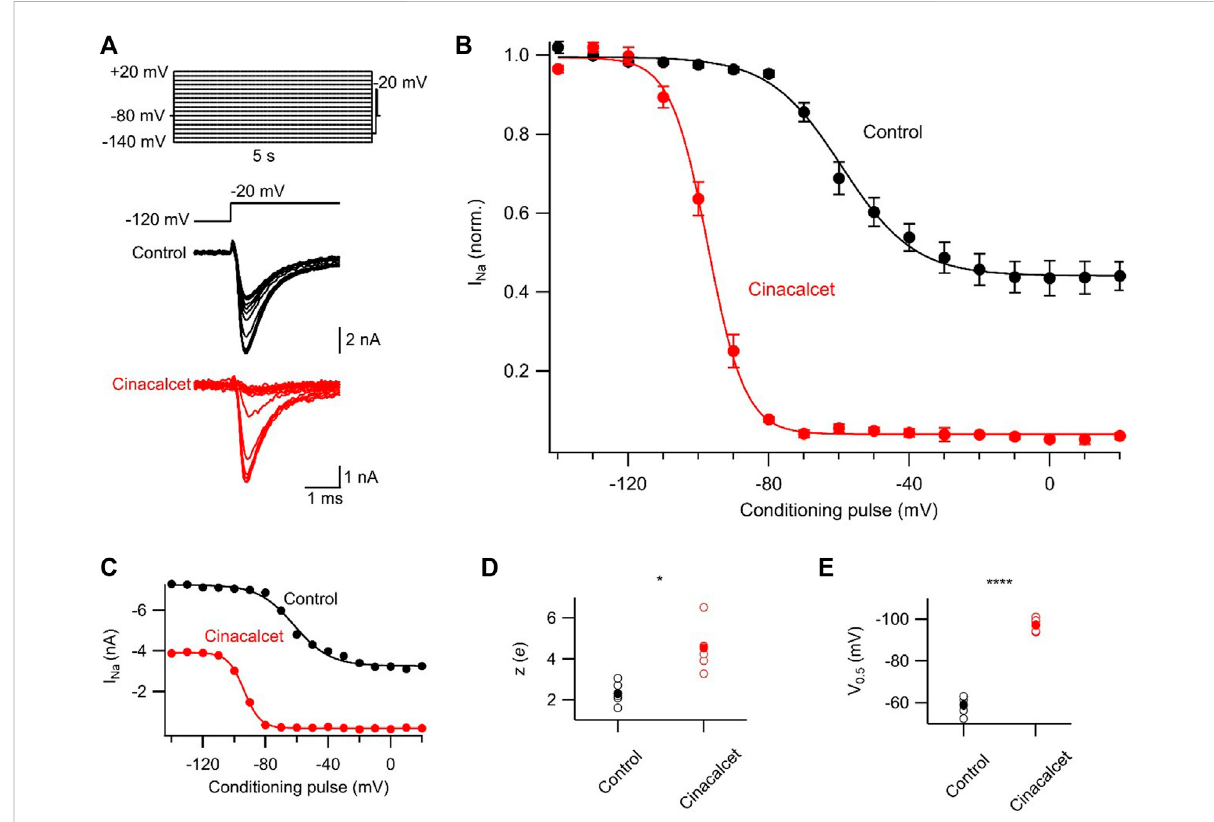
FIGURE 3 Cinacalcet enhancement of slowly recovering VGSCs. (A) Representative traces from a protocol used to isolate and evaluate the voltage- dependence of slow inactivation. Measurements were taken by applying a 5 s depolarization to varying voltages ( − 140 to +20 mV in 10 mV increments) fromaholdingpotentialof − 80mV,returningto − 120 mVfor 100 msto allowrecovery fromfastinactivation,anddeliveringatestpulse to − 20 mVincontrolconditions(black)andfollowingfullinhibitionby5 µMcinacalcet(red). (B) PlotofaveragenormalizedpeakVGSCcurrents elicited by test pulse following 5 s conditioning pulse and 100 ms recovery period in control (black; n = 6) and following full inhibition by cinacalcet (red; n = 6) fi t to the Boltzmann equation. Dashed red line indicates average cinacalcet fi t normalized to the average control maximum. (C) Plot of individual(black,opencircles)andmean(red, fi lledcircles)V 0.5 values. (D) Plotofindividual(black,opencircles)andmean(red, fi lledcircles)apparent valence